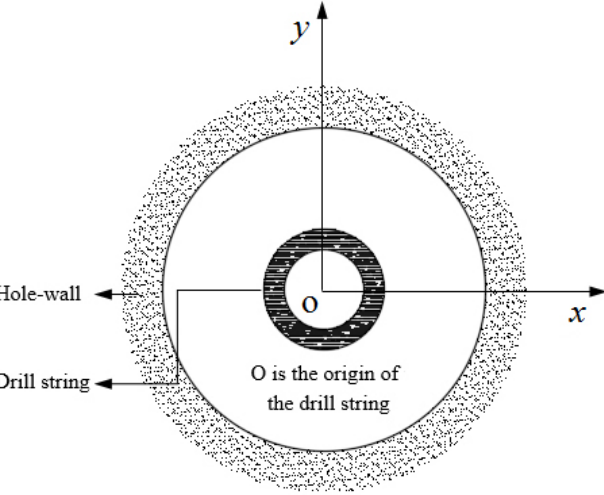
Figure 11. Coordinate system.